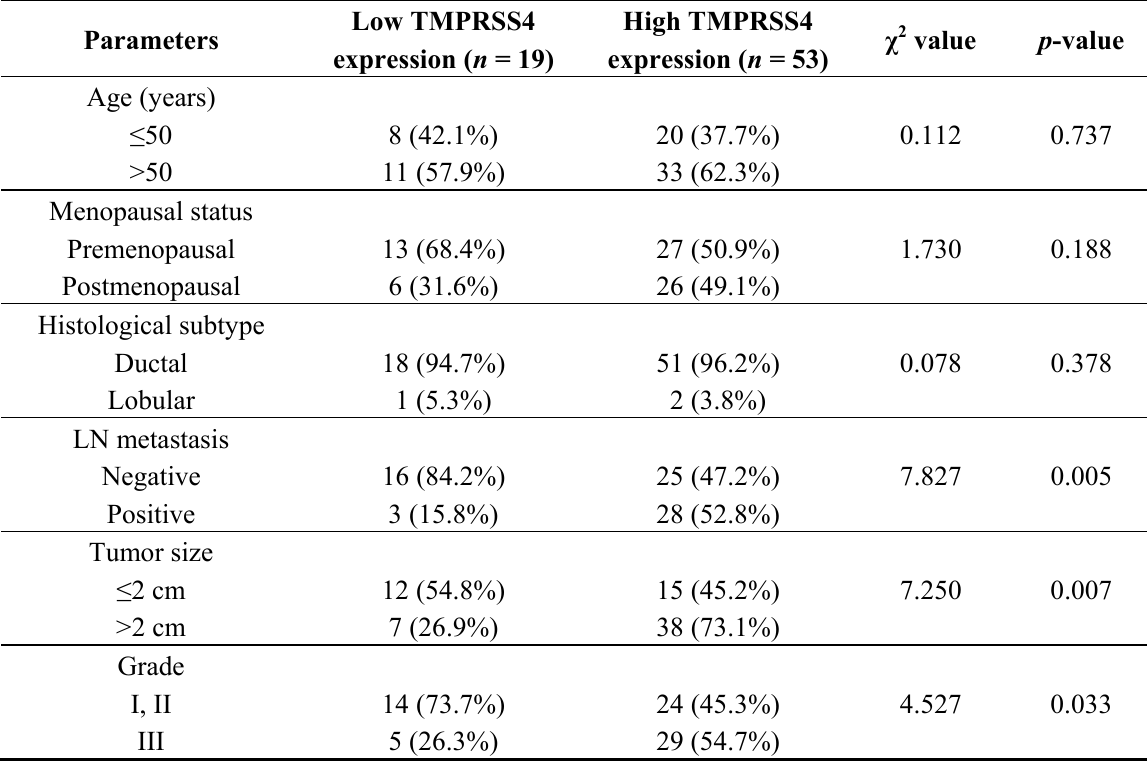
Table 2. Correlation between TMPRSS4 expression and clinicopathological parameters in TNBC